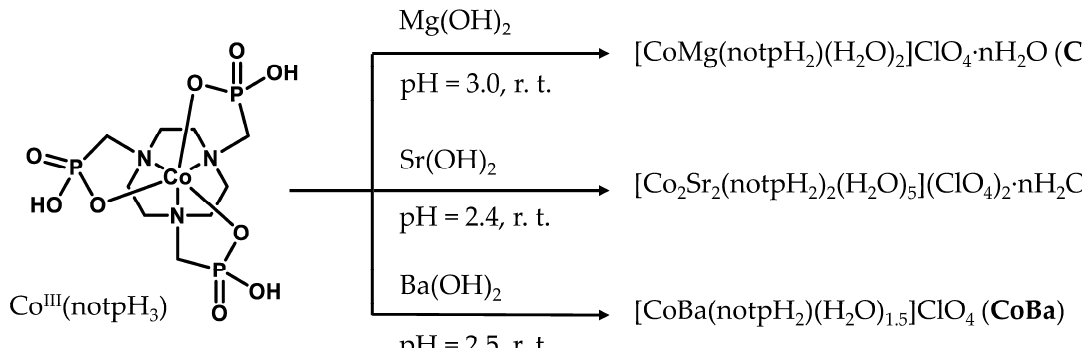
· nH 2 O, CoSr 2 O, and